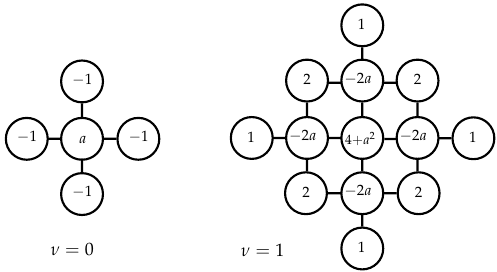
Figure 5. Non-zero elements of a column of the precision matrix Λ associated with one random variable and its neighbor vertices on a regular two-dimensional GMRF